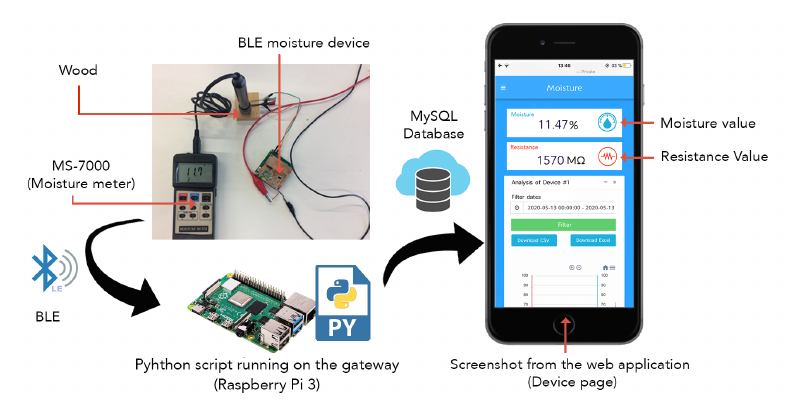
Figure 15. Testbench used to check the functionality of the system. The BLE device is connected to a Raspberry Pi 3 through BLE. The Raspberry receives the values, convert them to float and write them into the server database. The user can check the last stored values through the web application.